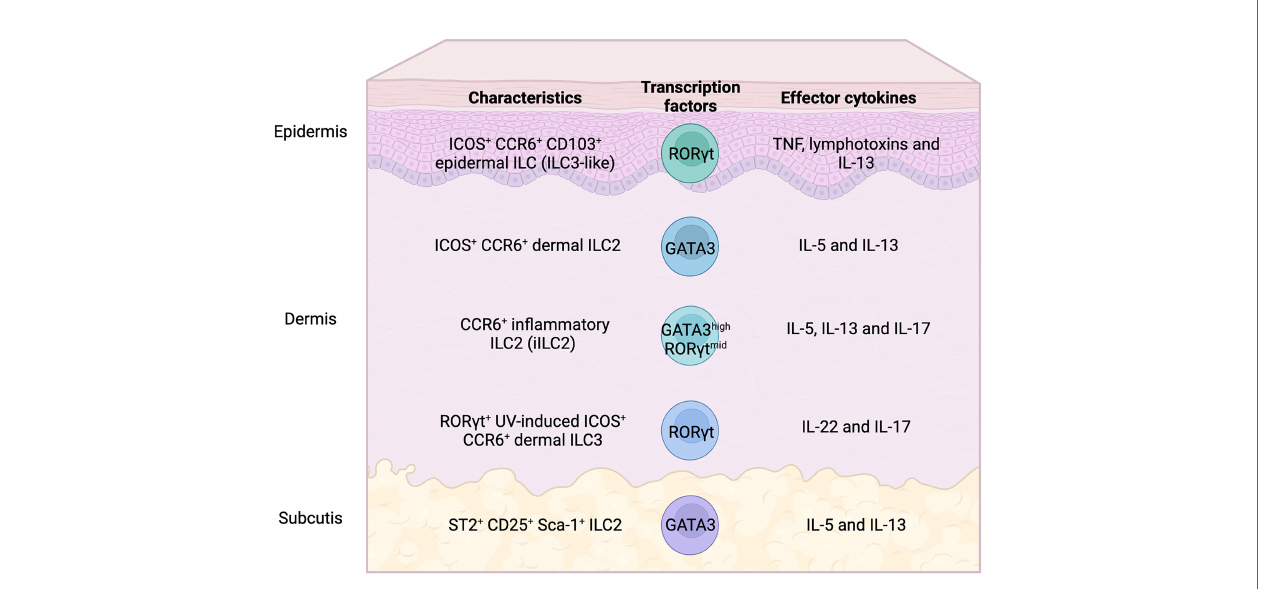
FIGURE 1 | Heterogeneity of skin ILC subsets in mice. Skin ILC2s, which produce IL-5 and IL-13, express ICOS and CCR6, but not ST2 (IL-33 receptor), and play an important role in atopic and allergic in fl ammation. ST2 + ILC2s are only found in subcutaneous adipose tissues. Epidermal ILCs also express ICOS and CCR6, display the characteristics of both ILC2 and ILC3, and regulate microbiome balance. In fl ammatory ILC2s that express both GATA3 and ROR g t produce IL-5, IL-13, and IL-17, which in fi ltrate the tissues under in fl ammatory conditions. IL-22- and IL-17-producing ROR g t+ ILC3s, which expand in UV-induced in fl ammation, also express ICOS and